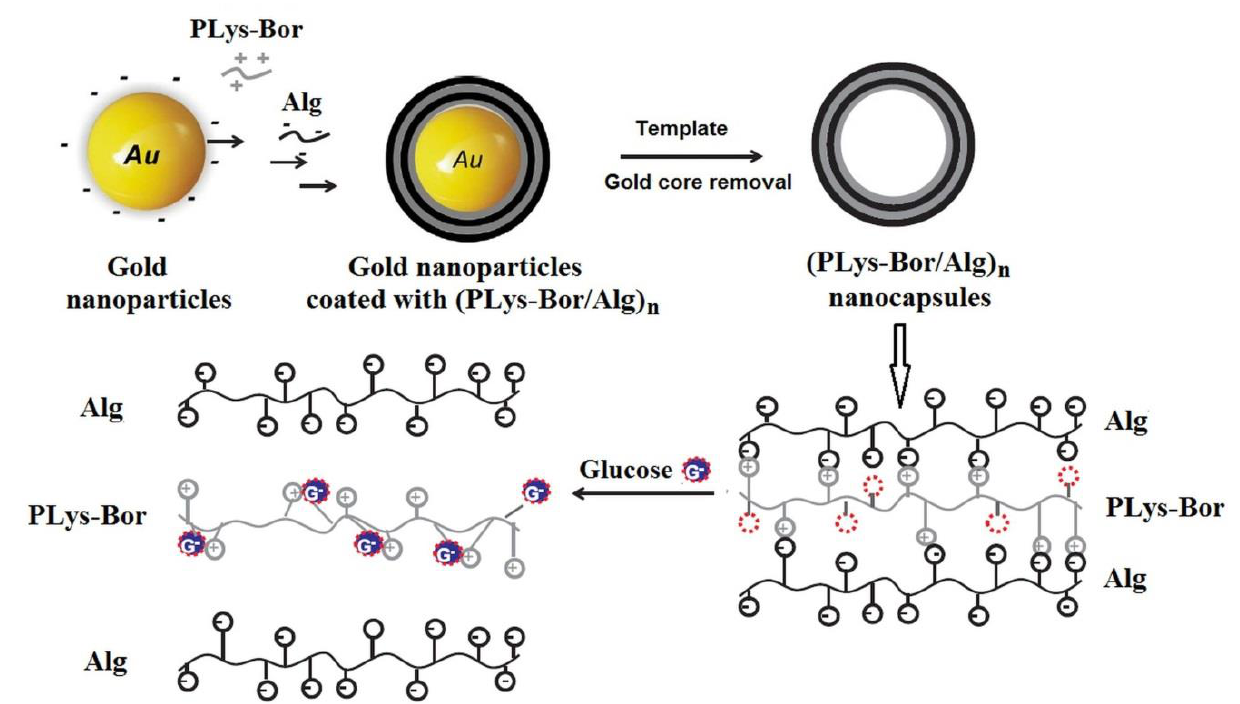
Figure 10. Illustration of the preparation strategy of (PLys-Bor/Alg) n nanocapsules and the disas- sembly of the multilayers in the presence of glucose (Adapted with permission from [96]. Copyright © 2023 Elsevier Ltd. All rights reserved).